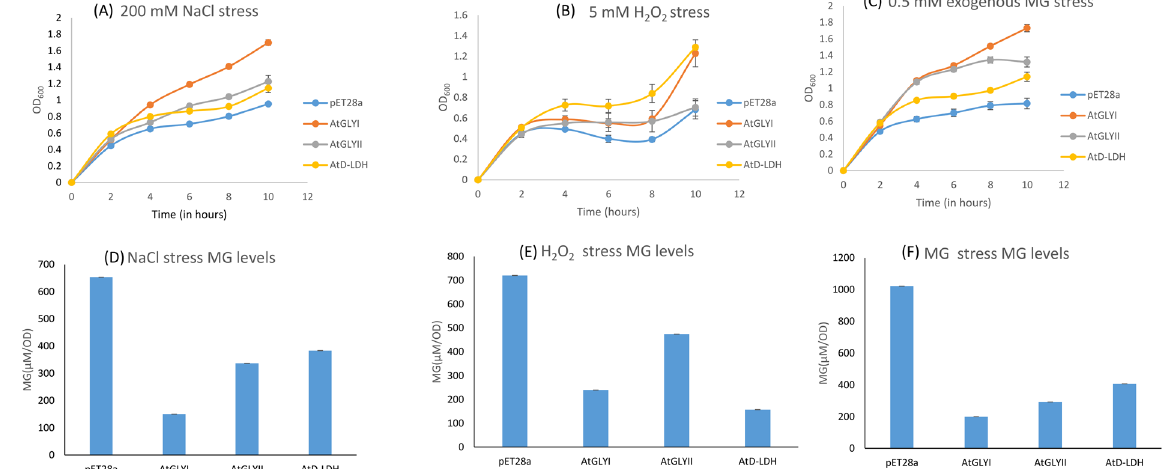
Figure 2. Heterologous expression of MG detoxification enzymes in E. coli provides varying tolerance to various abiotic stresses: The BL21 E. coli cells containing the constructs of MG detoxification genes (pET28a- AtGLYI, pET28a-AtGLYII and pET28a-AtD-LDH) were grown in presence of different abiotic stresses such as ( A ) salinity (200 mM NaCl), ( B ) oxidative (5 mM H 2 O 2 ) and ( C ) exogenous MG (0.5 mM MG) and their growth was monitored. Cells containing empty vector were used as